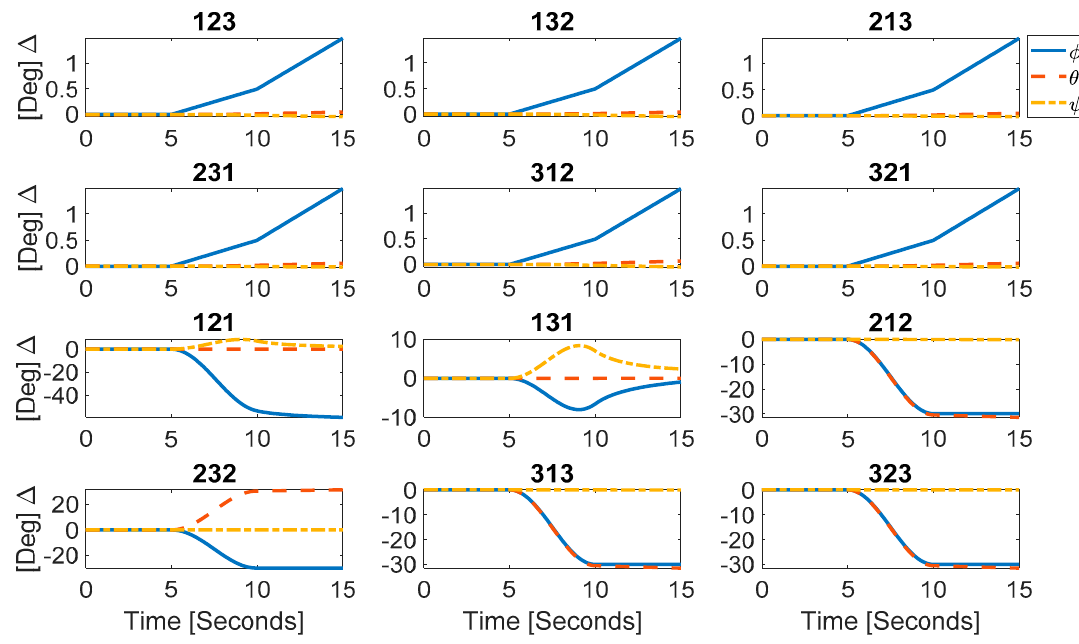
Figure 3. Corrected Euler Angles vs time for all 12 DCM rotations.